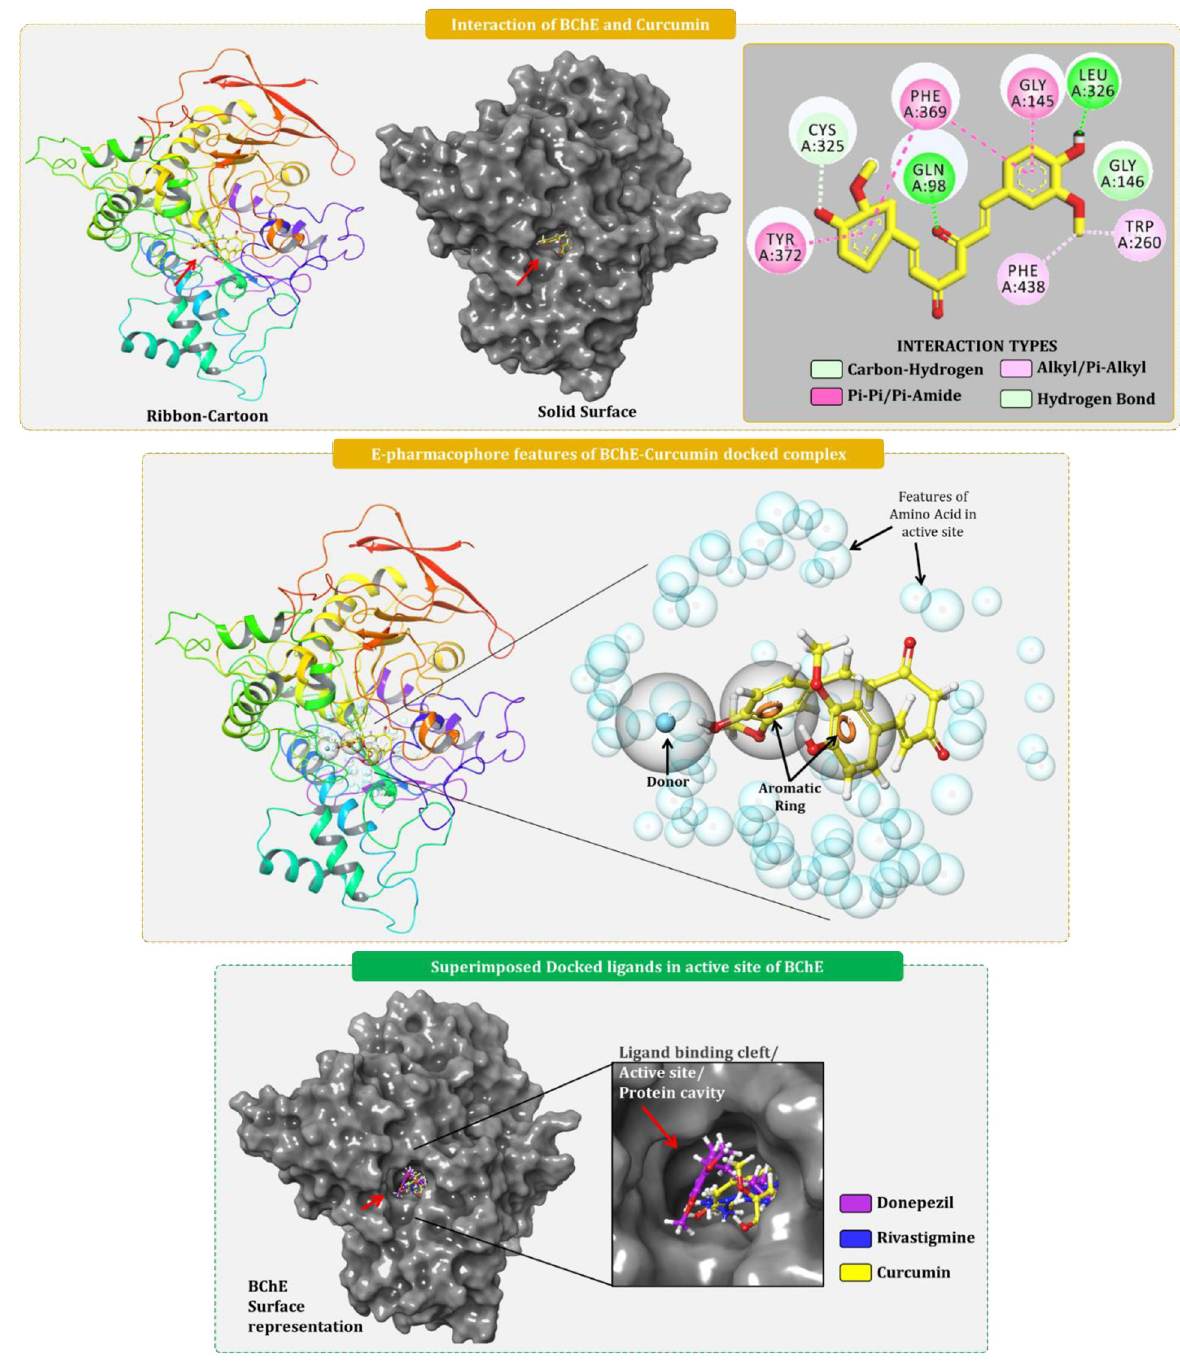
Fig 6. Docking assessment of curcumin with BChE and E-pharmacophore feature development of BChE-curcumin complex. (difference in HOMO and LUMO energy of a molecule) is used to calculate the molecular sta- bilization and activity of the molecules. Smaller the energy gap, highly reactive and stable the compound is. In this case, HOMO, LUMO and optimized geometry of curcumin, donepezil and rivastigmine is represented in Fig 7. Firstly, mentioning the reference drugs, for donepezil